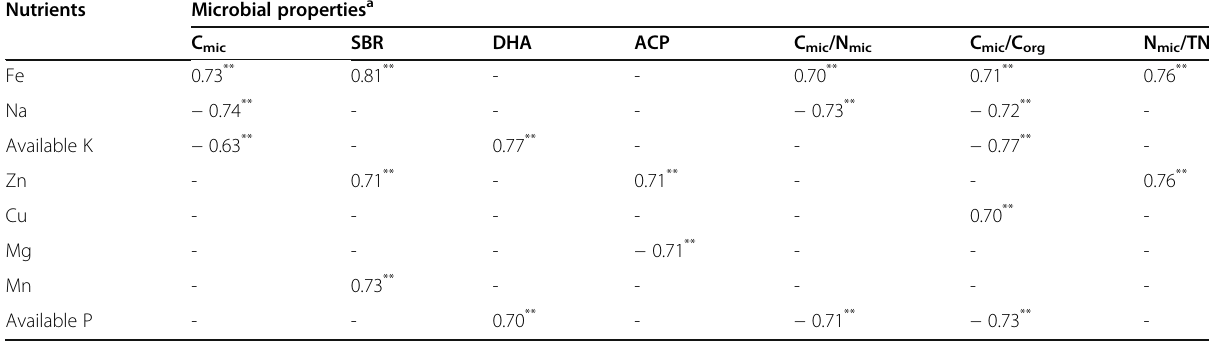
Table 5 Correlation between microbial properties and nutrients of soil in oak and pine forests of Tehri and Pauri Garhwal Nutrients Microbial properties